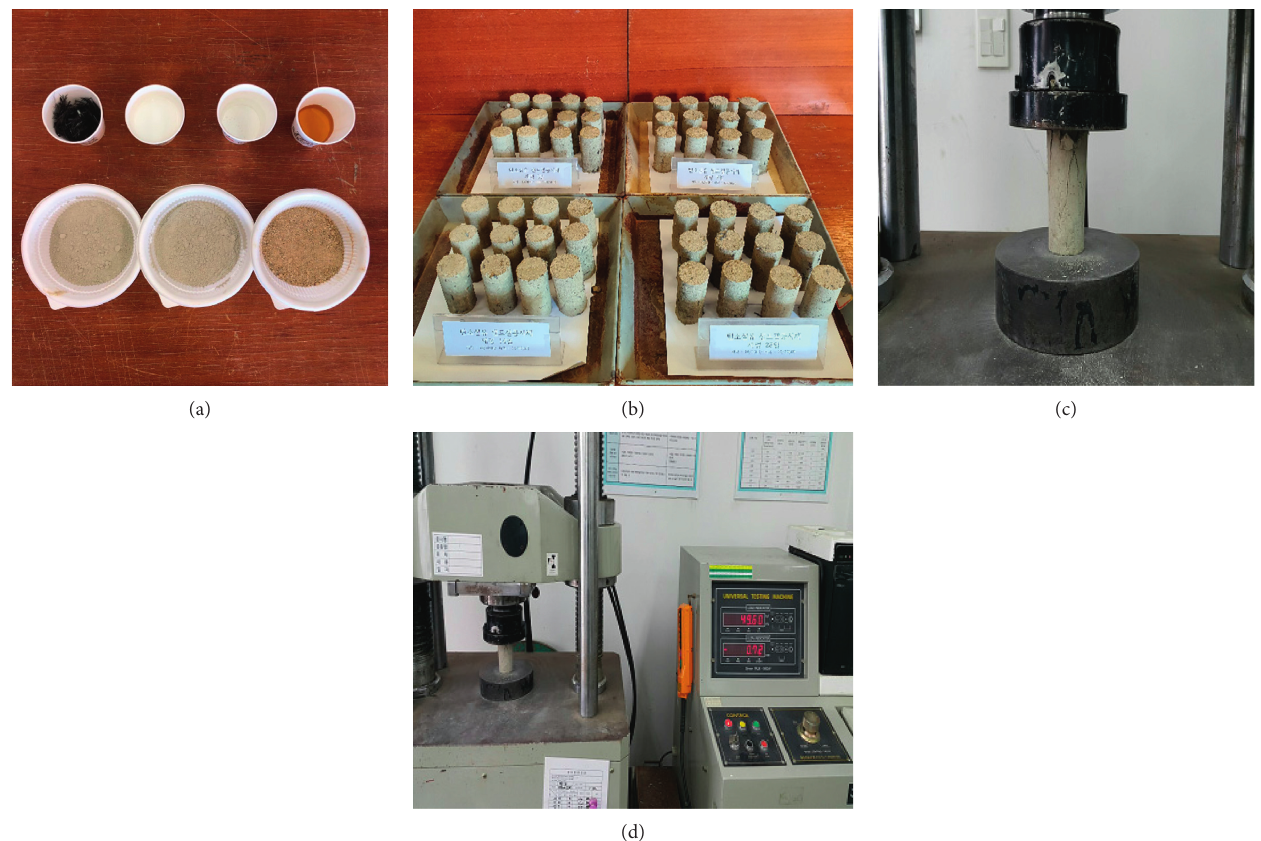
Figure 3: Process of uniaxial compression test: (a) material mixing; (b) aerial curing; (c) uniaxial compression test; (d) shape of test specimens after